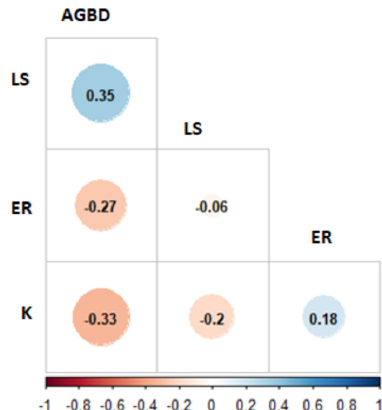
Figure 6. Correlation analysis between the LS, ER, K, and ABGD values at parcel levels. All the reported correlation coefficients are calculated with the 95% significant level and have p -values < 0.001.